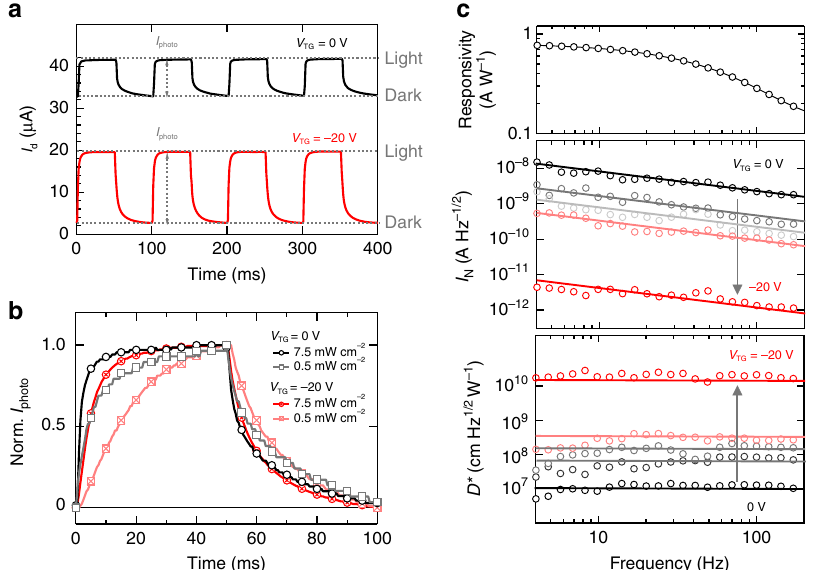
Fig. 3 Photodetection performance of dual-gate organic phototransistor. a Transient response of drain current with and without top gate bias ( V TG = 0, − 20 V), operating at fi xed source-drain bias of 5 V and V BG of 20 V. A monochromatic light source was employed for excitation (543 nm, 10 mWcm